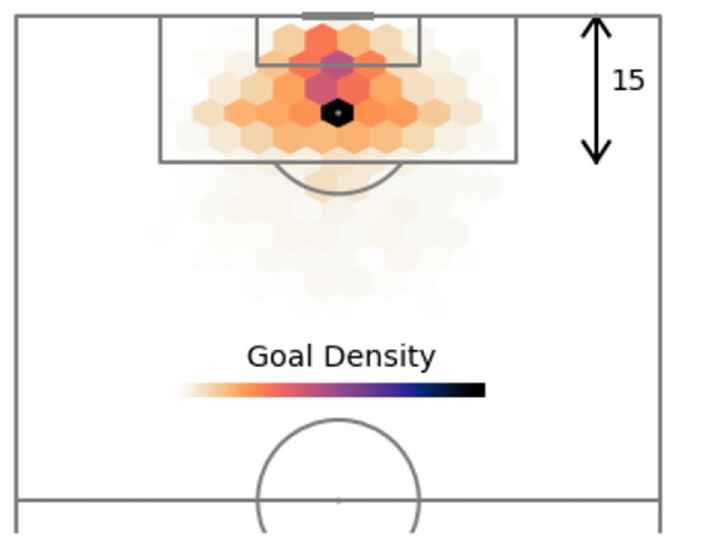
before half-time ( * 2700 seconds), maybe because teams recognise the value in maintaining a scoreline until half-time, when they can reevaluate and gain feedback, instead of risking losing their lead or conceding more if they increase attacking efforts, thus weakening their defensive structure. After half-time, perhaps as teams have changed tactically, or simply as both teams take greater risks with less time left to affect the scoreline, the likelihood of a shot resulting in a goal increases significantly to where there is more chance of a shot being goal than it being saved, off-target or blocked.